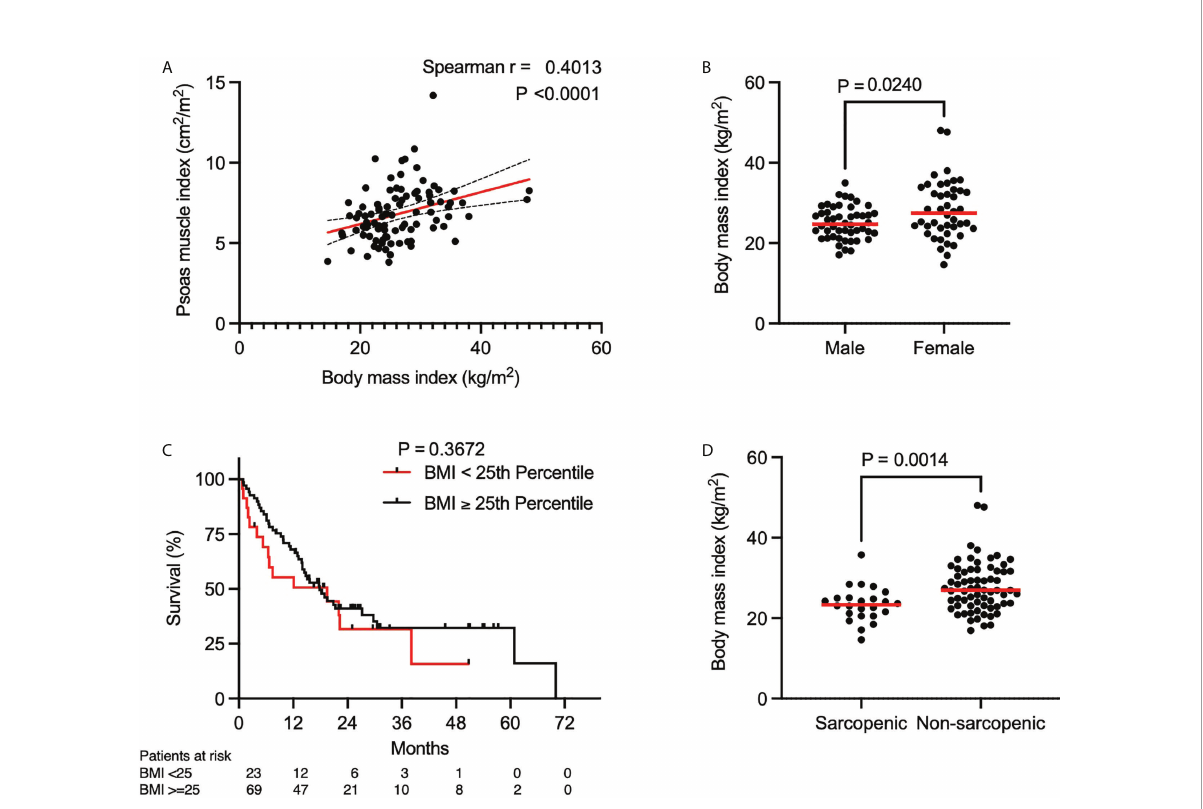
FIGURE 2 Association of psoas muscle index and body mass index. (A) Spearman correlation between BMI and PMI. Red line indicates the line of best fi t. Dashed lines above and below the red line indicate the 95% con fi dence bands of the best fi t line. (B) BMI strati fi ed by gender (n = 92). P value calculated using the Mann-Whitney U test. (C) Kaplan-Meier curve depicting survival analysis based on BMI. P value calculated with the log-rank test. Each tick mark on the Kaplan-Meier curve represents a censored event. (D) BMI strati fi ed by sarcopenia (n = 92). P value calculated using the Mann-Whitney U test. Each data point represents an individual patient. Red lines in (B, D) indicate the median of each